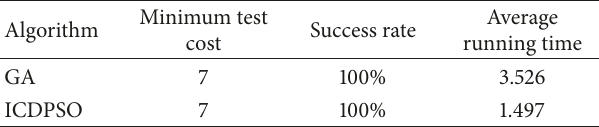
Table 4: The statistical results of GA and